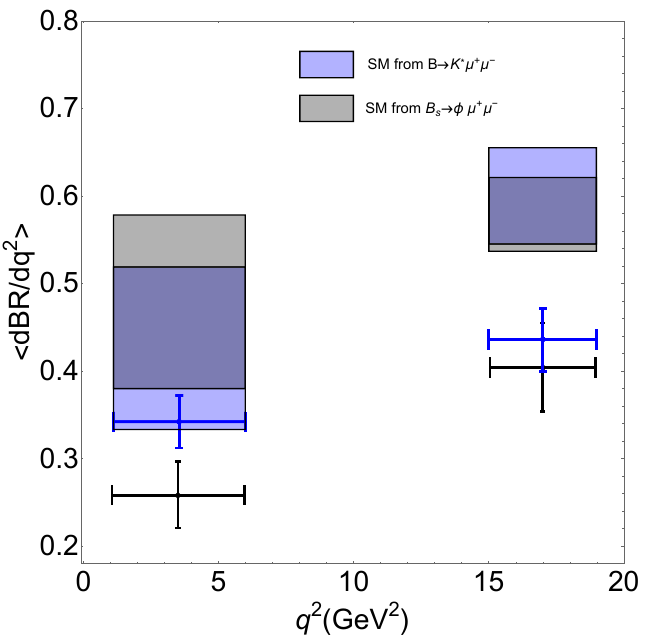
+ µ ( B ) and ( B K ∗ µ + µ − ) within the SM along − s → φµ B B →